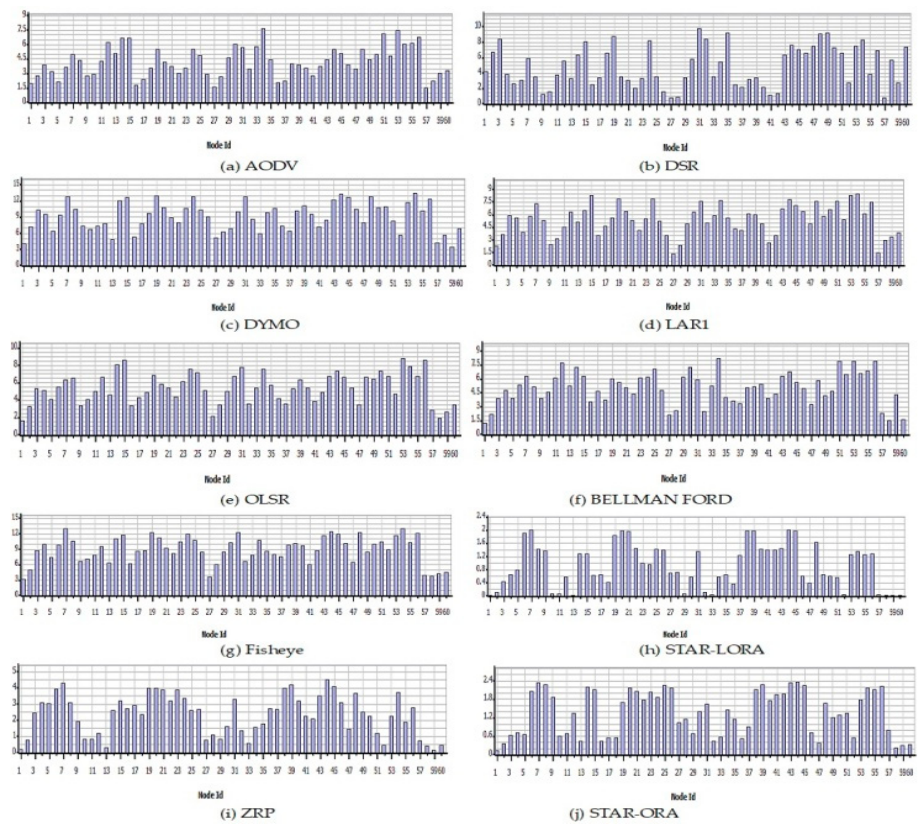
Figure 11. Receive mode power consumption (mWh) for various routing protocols.